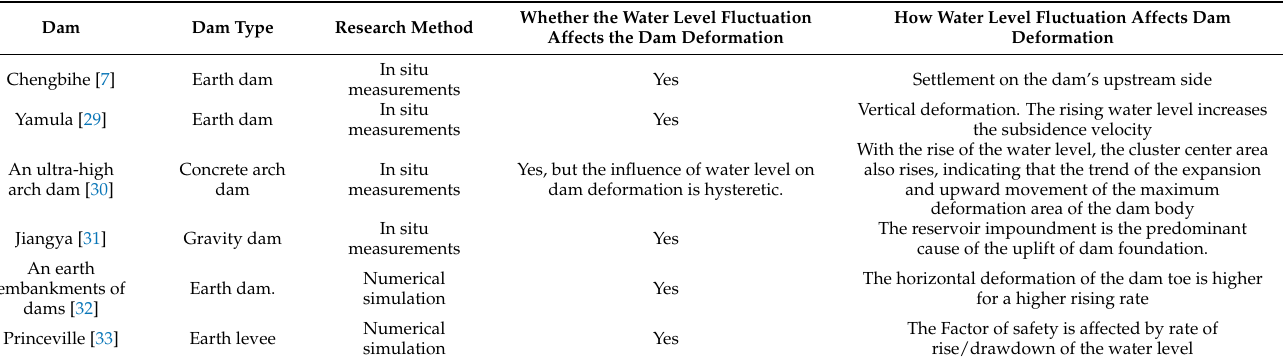
Table 5. Study on the effect of water level fluctuation on dam